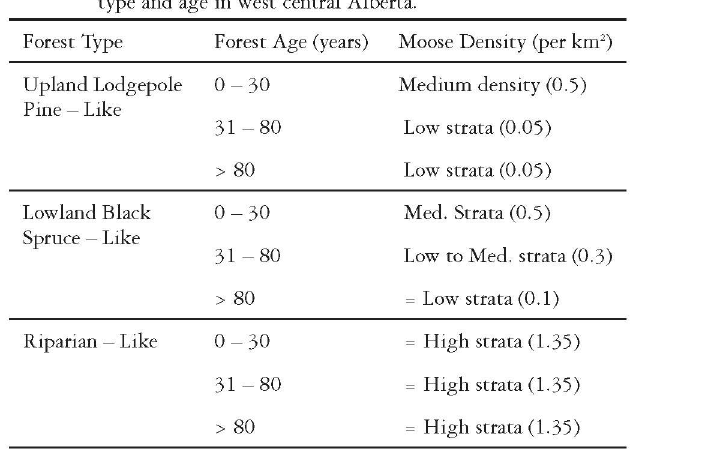
Table 1. Moose densities 1 used in the REMUS Model based on forest type and age in west central